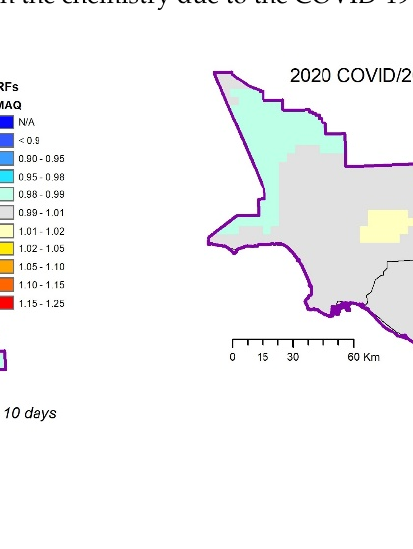
Figure 9. CMAQ derived RRFs: ( a ) 2020 COVID/2019 Base; ( b ) 2020 COVID/2020 BAU.